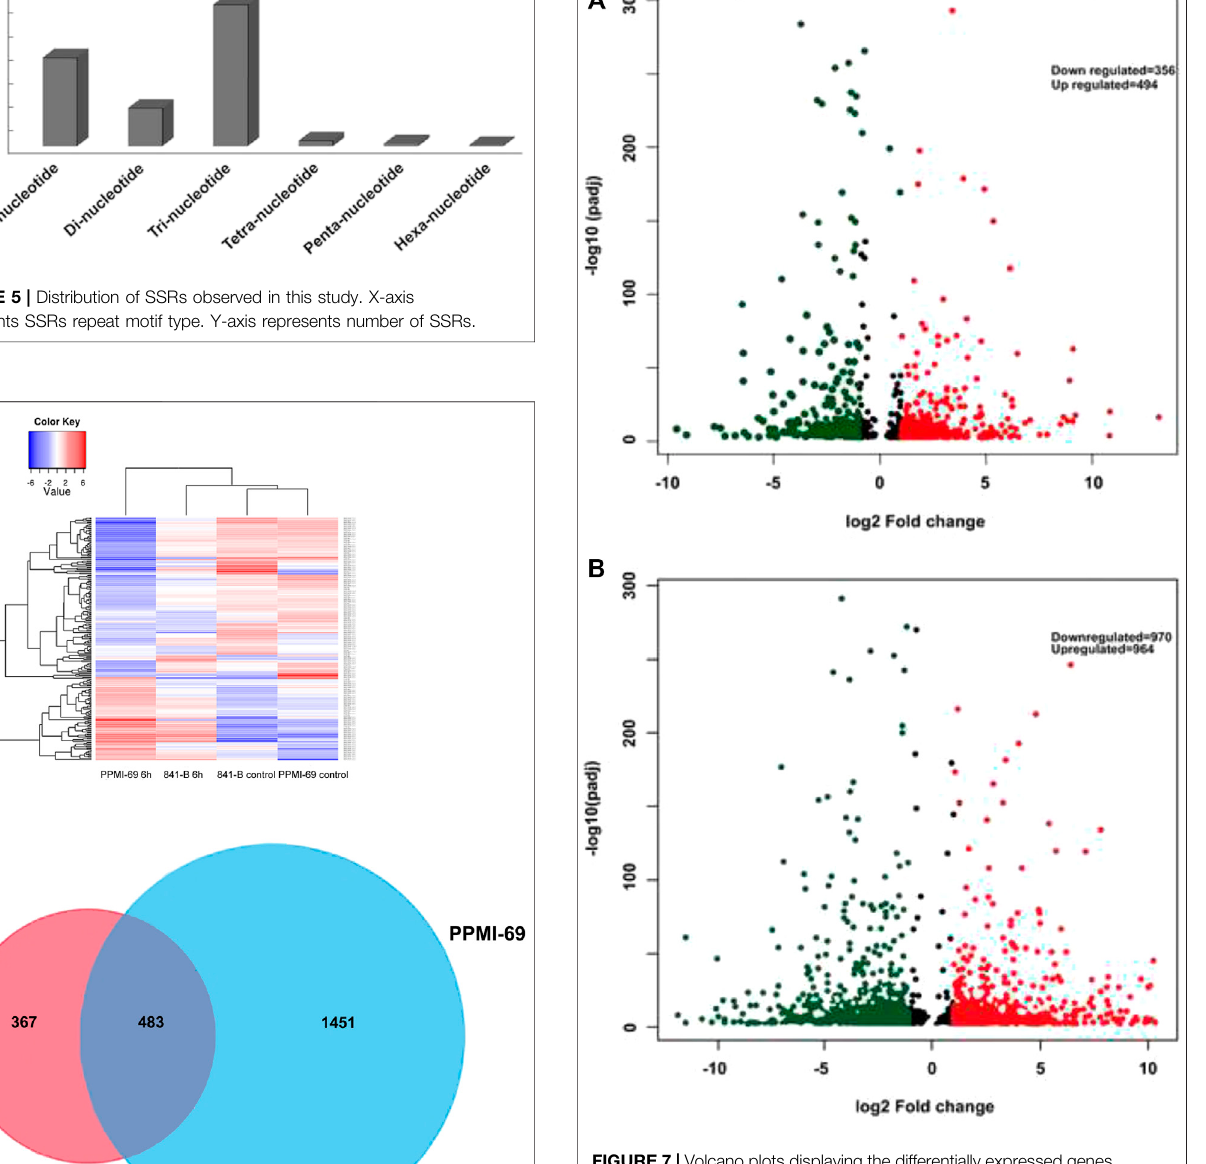
FIGURE 7 | Volcano plots displaying the differentially expressed genes. (A) - 841-B genotype. (B) - PPMI-69 genotype. Red color represents upregulated genes, green color indicates downregulated genes, while nonsigni fi cant genes are shown as black